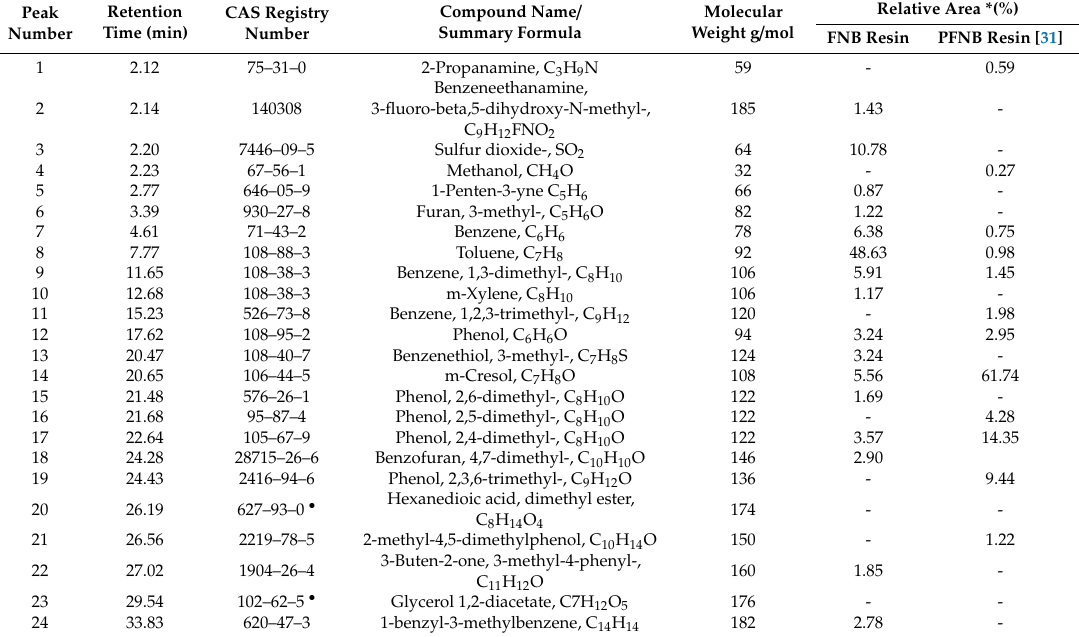
Table 5. Identified pyrolysis products of cured resin FNB and PFNB at 1100 ◦